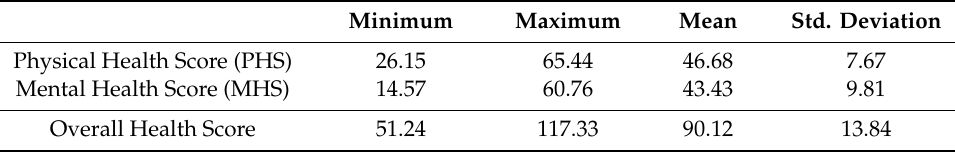
Table 1. Summary of Physical, Mental and Overall Health Measures.